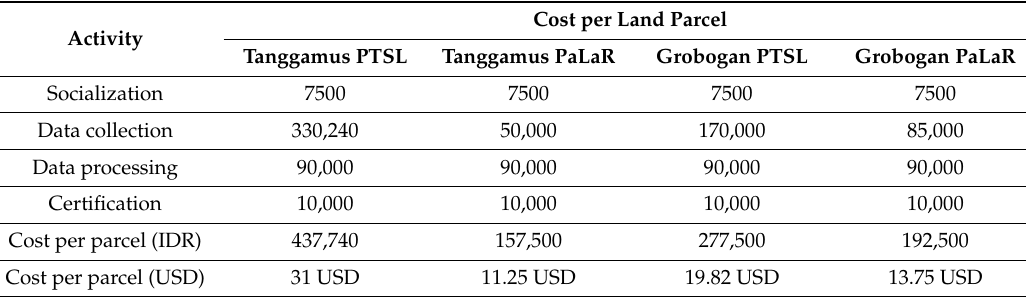
Table 5. Cost simulation and comparison between PTSL and PaLaR